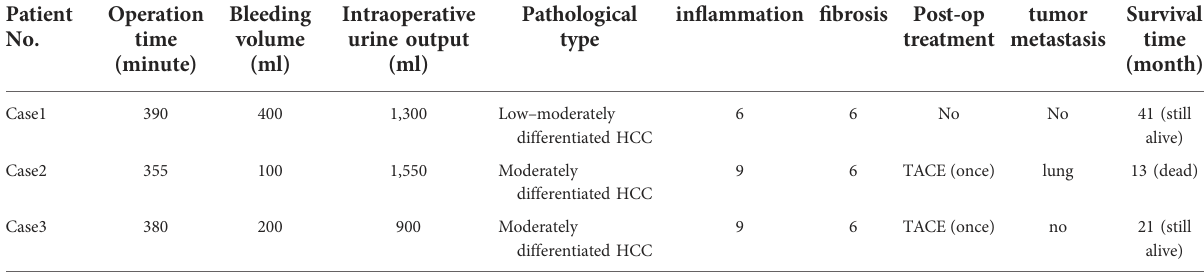
TACE, Transcatheter arterial chemoembolization.